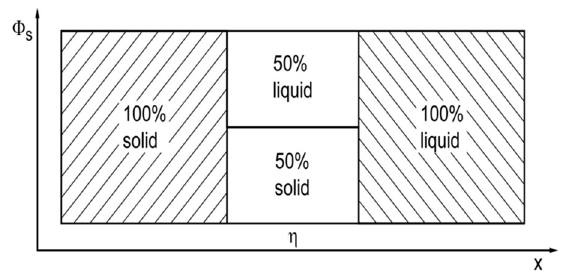
Figure 4. The entropy distribution of the Jackson model generates Φ = 0.5 as the most probable value in the interface region.